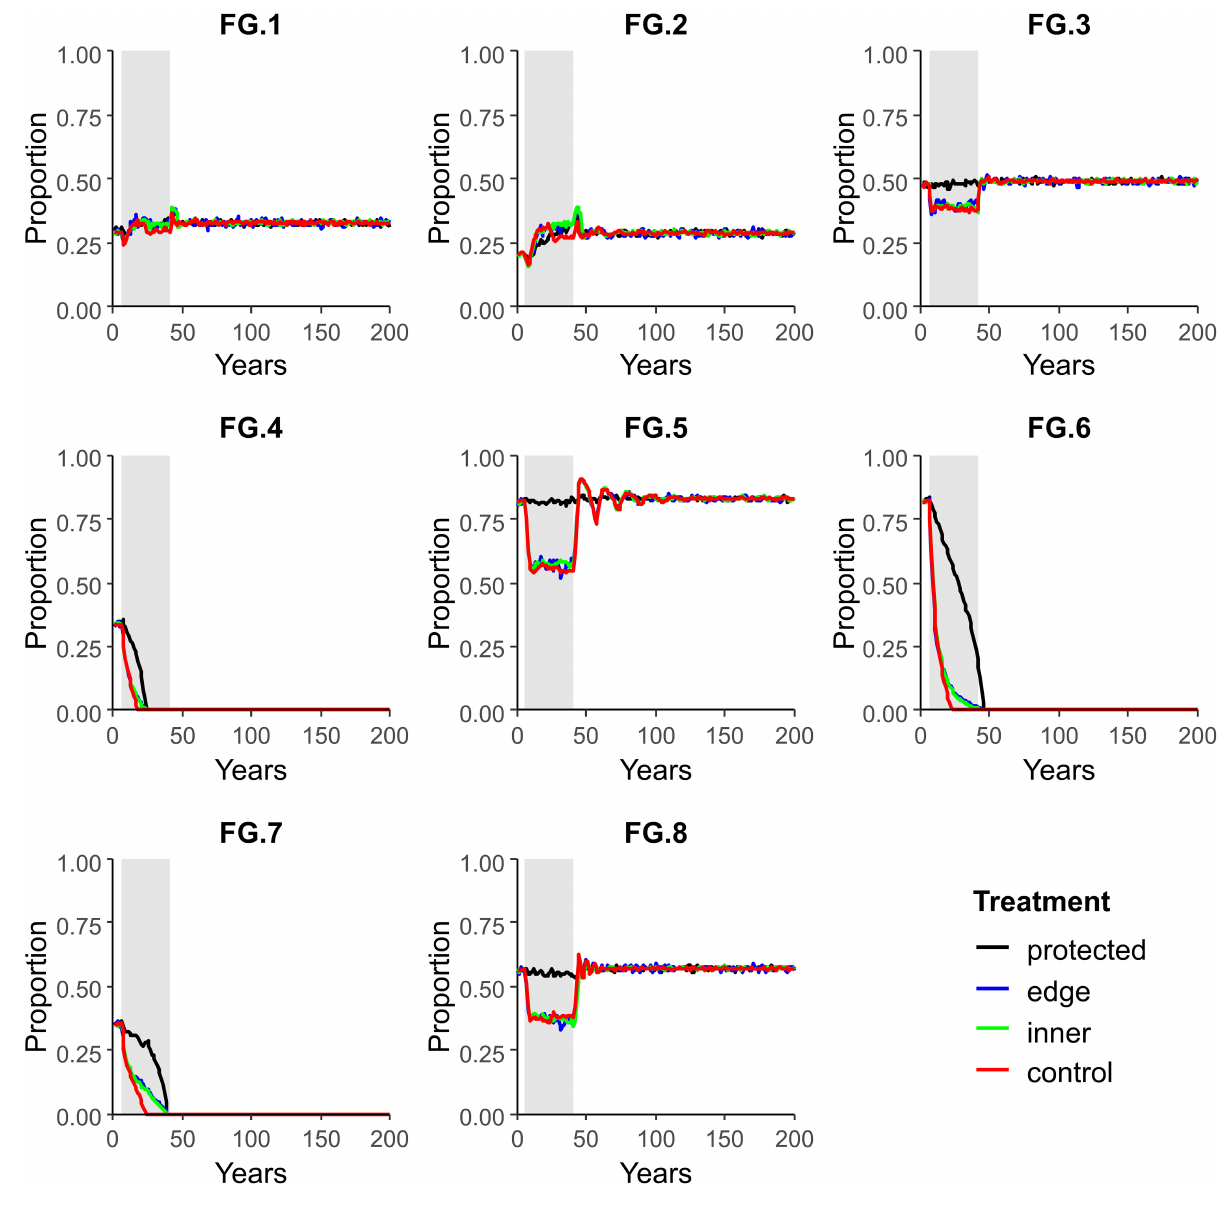
FIGURE 5 | Proportion of seascape occupied by adults of each FG over time in four regions within the model seascape (“inner disturbed” and “edge disturbed” where disturbances were simulated; “protected” where no disturbances were simulated; and “no protection” which was a separate model, with the same dimensions as the impact area but included no protected areas). Scenario parameterized with a 20% disturbance per year for 35 years within an impact area of 75% of the total model area (25% of the area in benthic protected